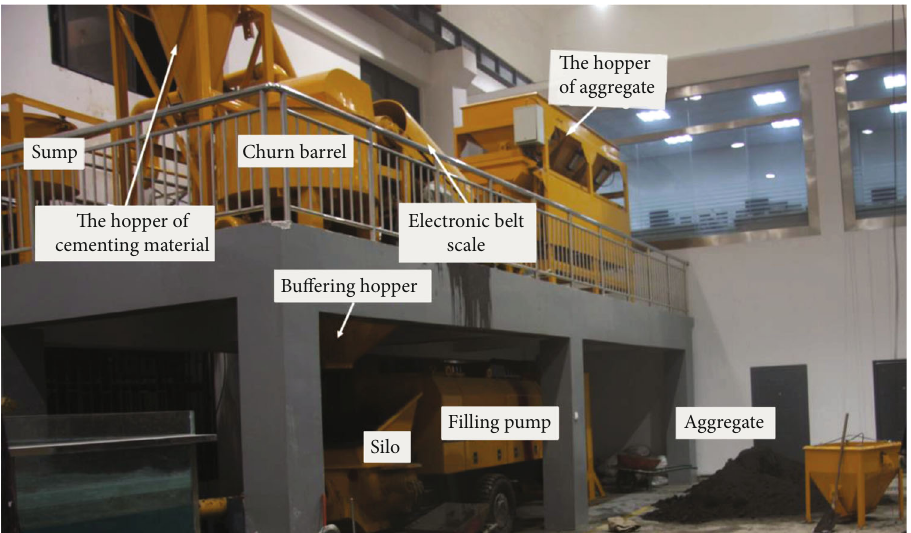
Figure 10: Paste proportioning and indoor test of pipeline transportation.